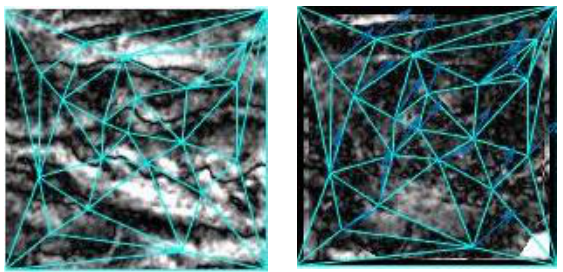
Figure 6. TIN construction and shift vector for each point in area #1. Grey values depict height difference value per point: before morphing (left) and after (right).